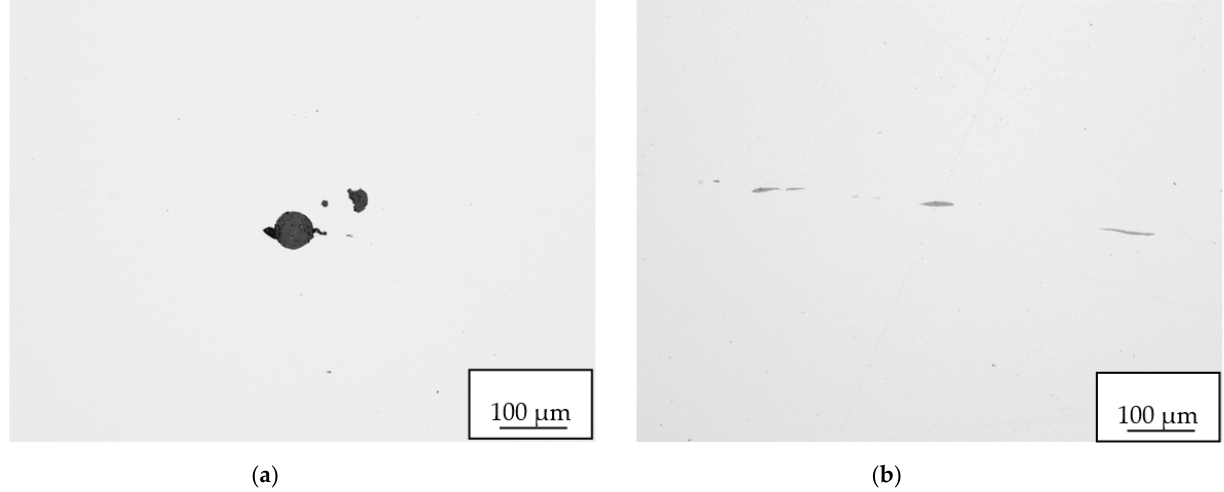
Figure 10. Non-metallic inclusions in the centre of steel plate (sample 1). ( a ) Excessive D-type oxidic inclusions in metal matrix; ( b ) Sulfidic inclusions founded in metal matrix.